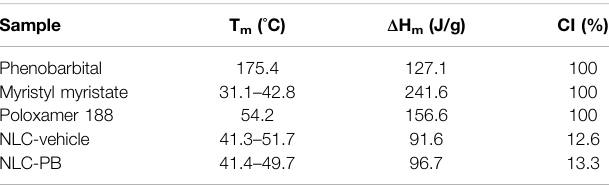
TABLE4| Meltingpoints(T m ),meltingheat( Δ H m ),andcrystallinityindex(CI)ofraw materials and NPs with and without PB. Crystallinity indexes of NLC-vehicle and NLC-PB were calculated according to Eq. 3 .